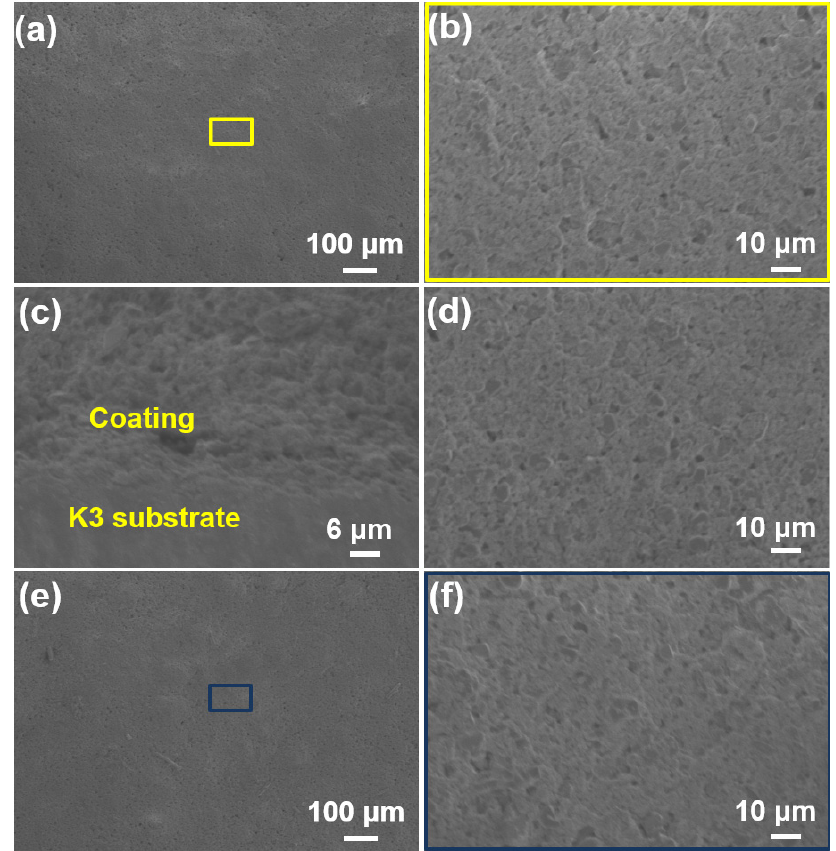
Figure 8. SEM images of the SiOC/Al 2 O 3 /YSZ coatings after oxidation test at 1000 °C for different times: ( a – c ) for 12 h, ( a , b ) surface-section, ( c ) cross-section; ( d ) for 24 h, surface-section; and ( e , f ) for 36 h, surface-section.